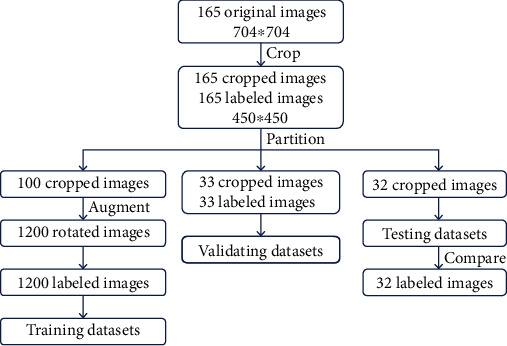
Data preprocessing.